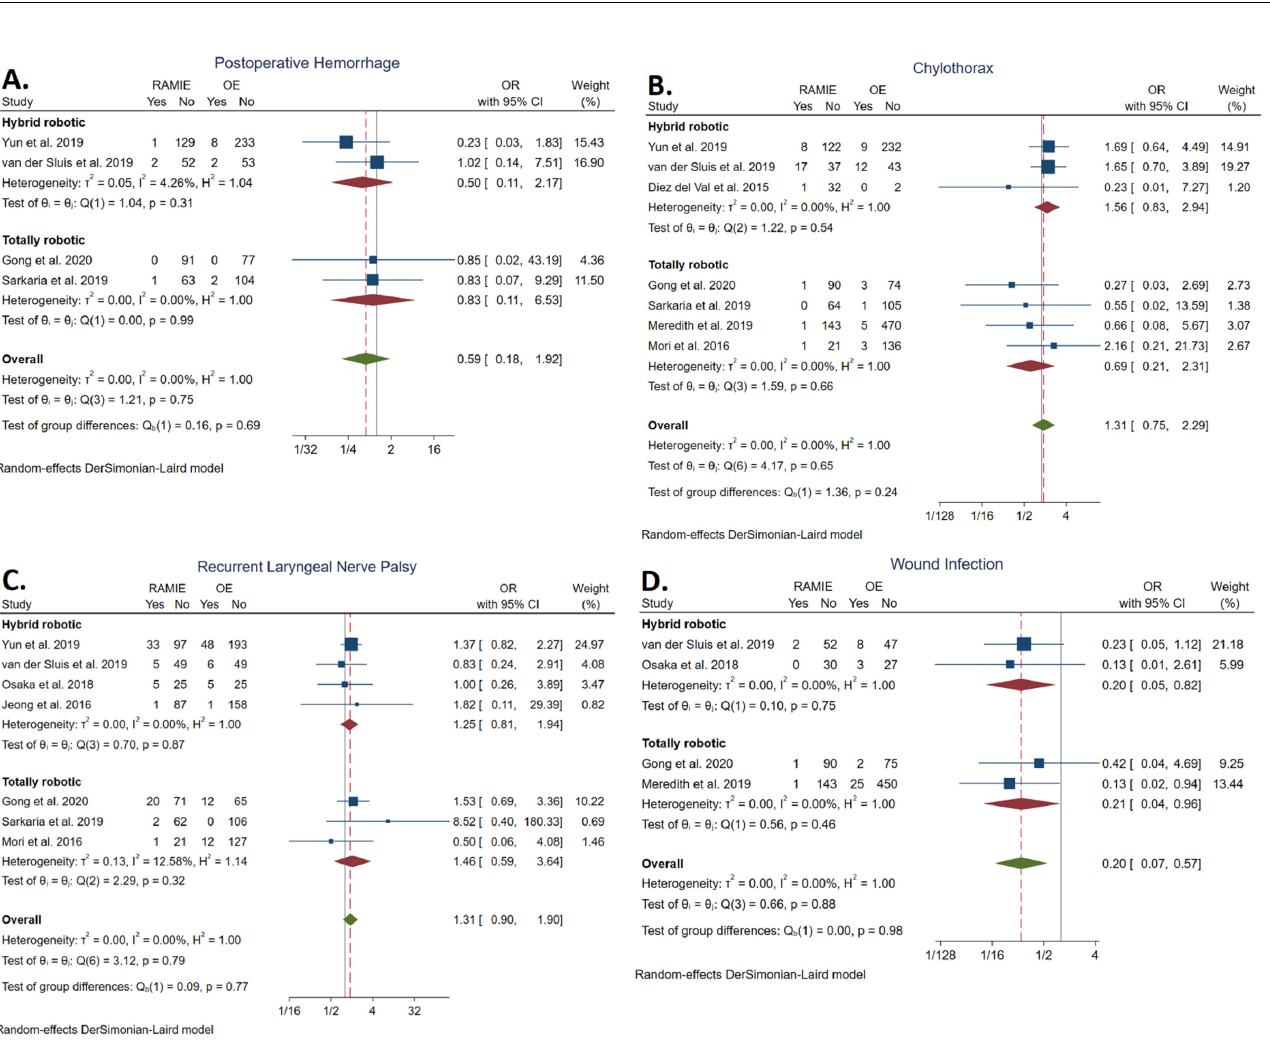
Figure 6. Forest plots of postoperative hemorrhage rate ( A ), chylothorax rate ( B ), recurrent laryngeal nerve palsy rate ( C ), and wound infection rate ( D )